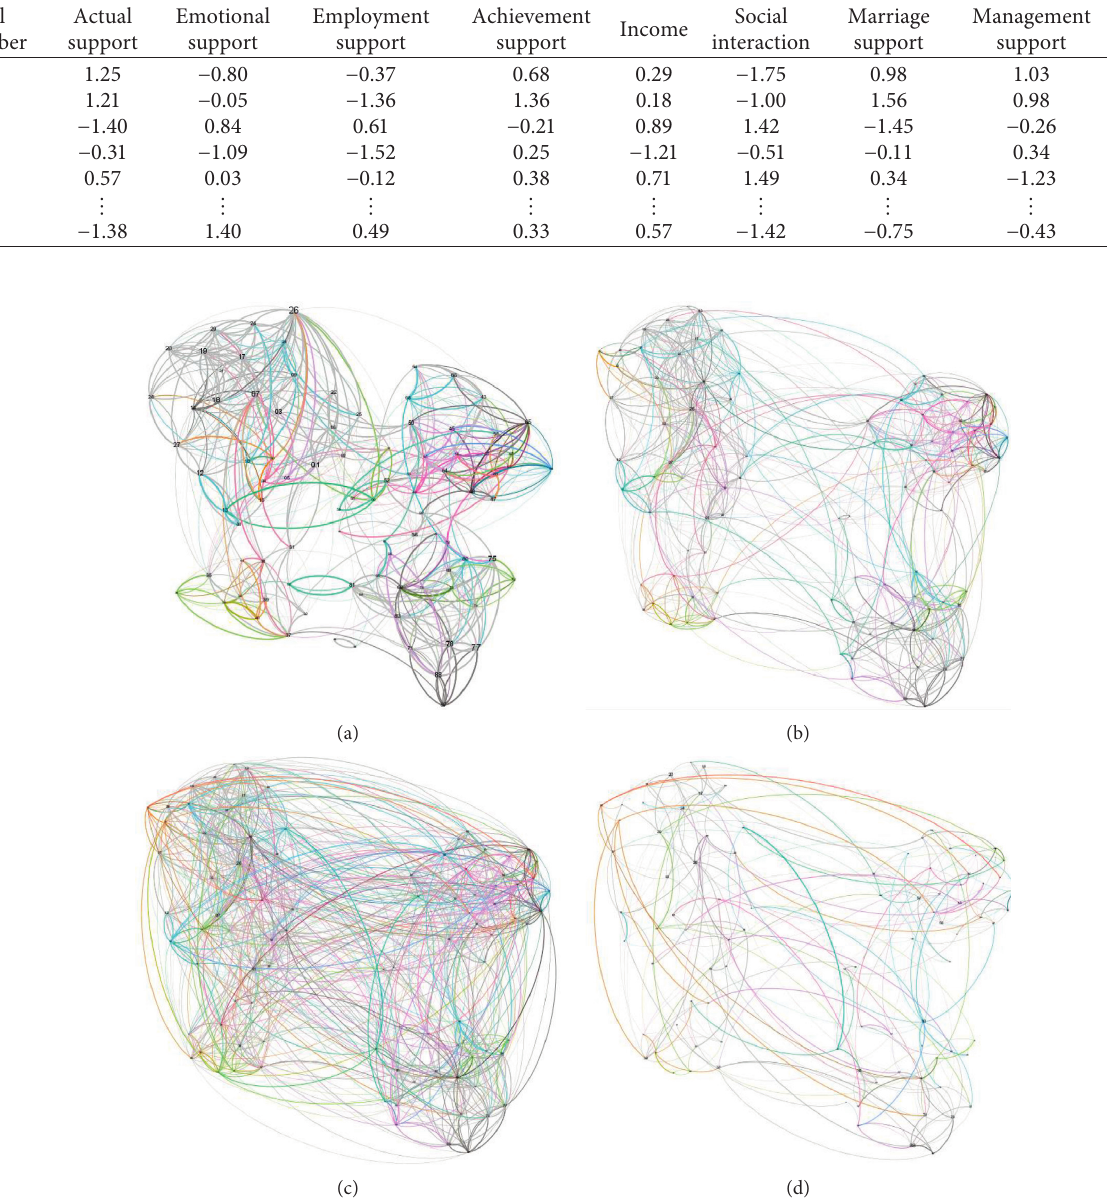
Table 2: Normalization of social support attributes of athletes.